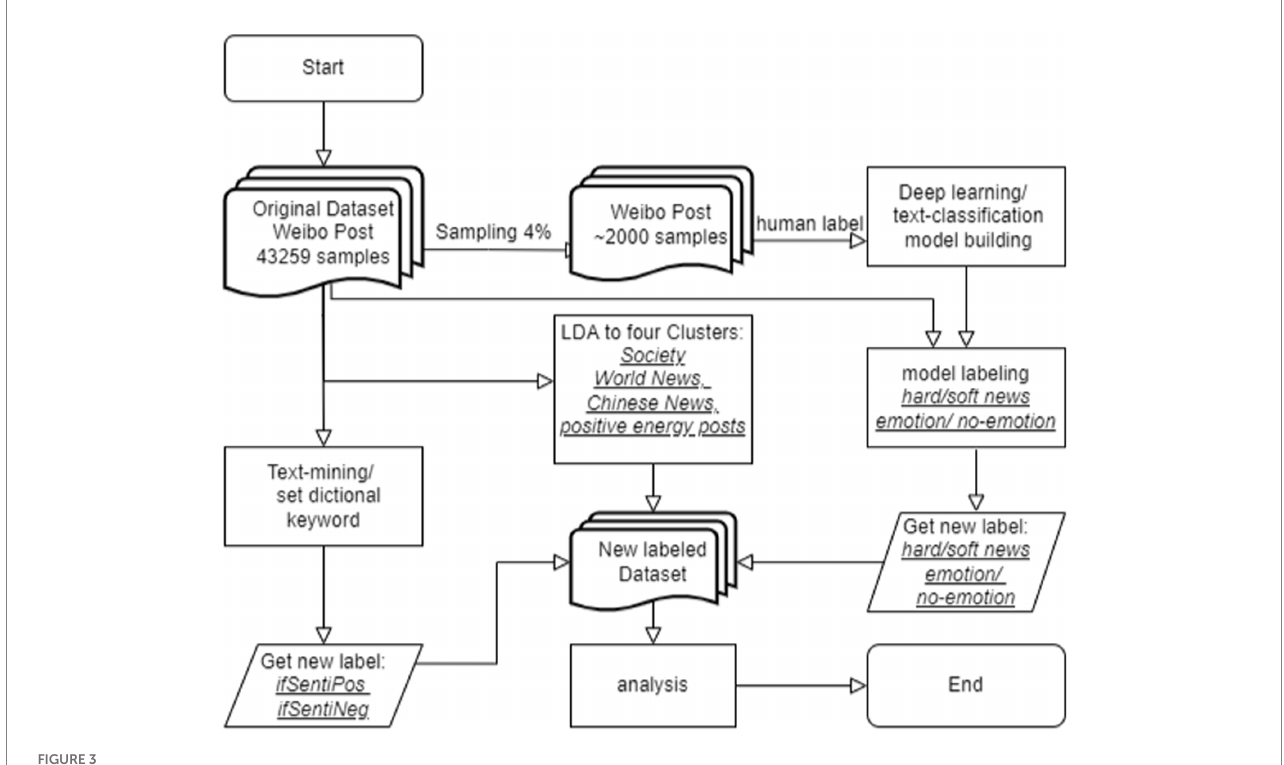
FIGURE 3 Research